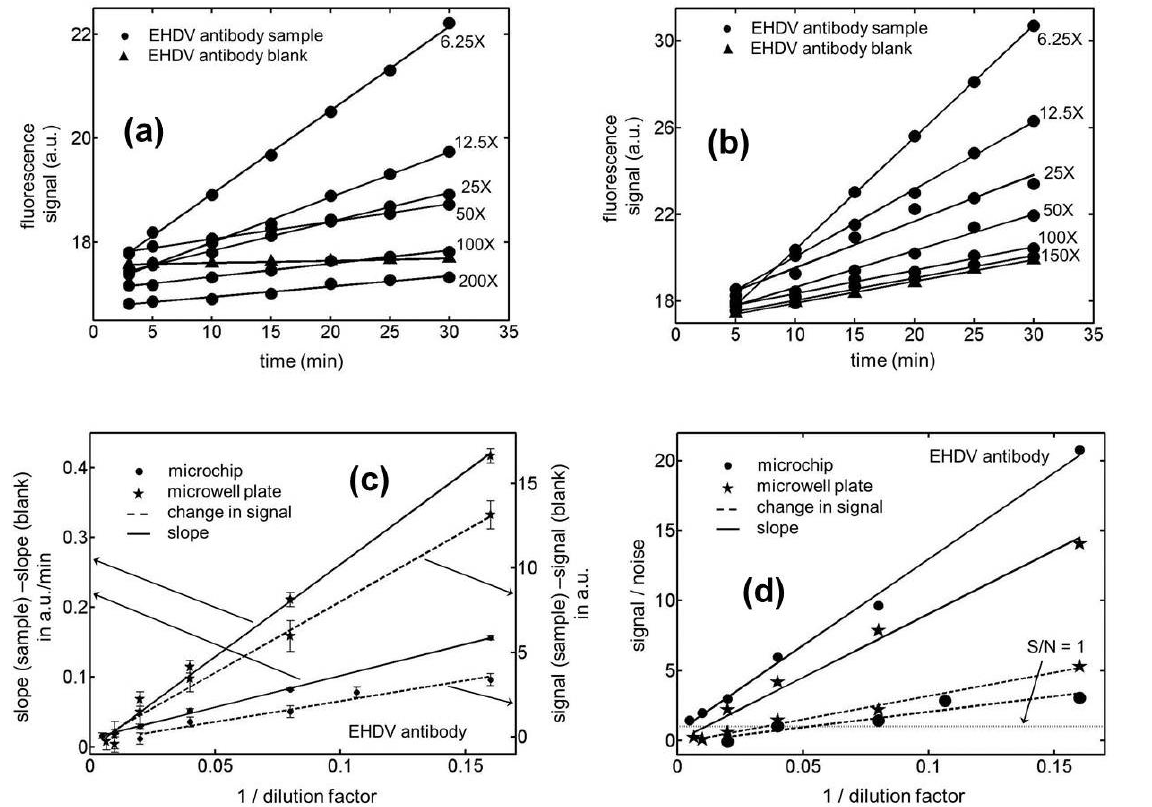
Figure 3. Temporal variation in the fluorescence signal for Epizootic Hemorrhagic Disease Virus (EHDV) antibody samples in ( a ) microchannels ( b ) microwells with an active ELISA surface. ( c ) Calibration curves for the kinetic and end-point ELISAs in microchips and microwell plates for EHDV antibody samples. ( d ) Limit of detection (LOD) curves for the kinetic and end-point ELISAs in microchannels and microwells for the EHDV antibody samples. Notice that the x -coordinate in (c) and (d) has been chosen to be the reciprocal of dilution factor rather than the dilution factor itself. Our analyses show that if the latter choice is made, the linear variation between the x and y data points is